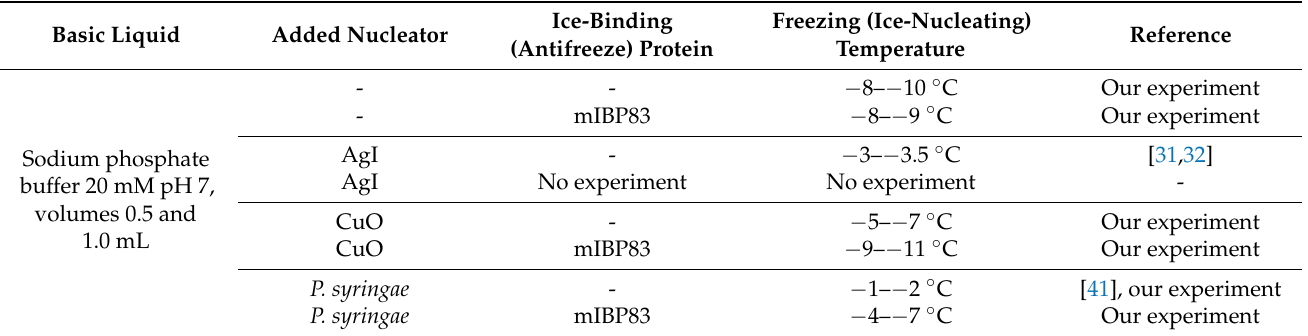
Table 3. Freezing (ice-nucleating) temperatures for explored liquids in standard plastic (polypropy- lene) test